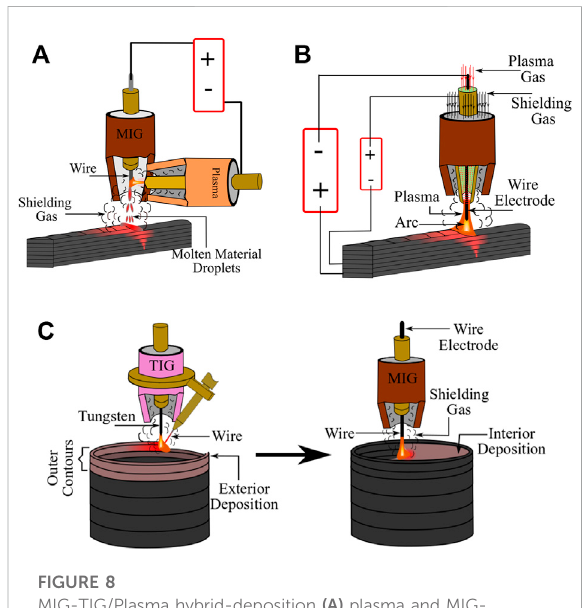
FIGURE 8 MIG-TIG/Plasma hybrid-deposition (A) plasma and MIG- based micro-casting, (B) plasma-assisted MIG deposition, and (C) Feature-based TIG and MIG